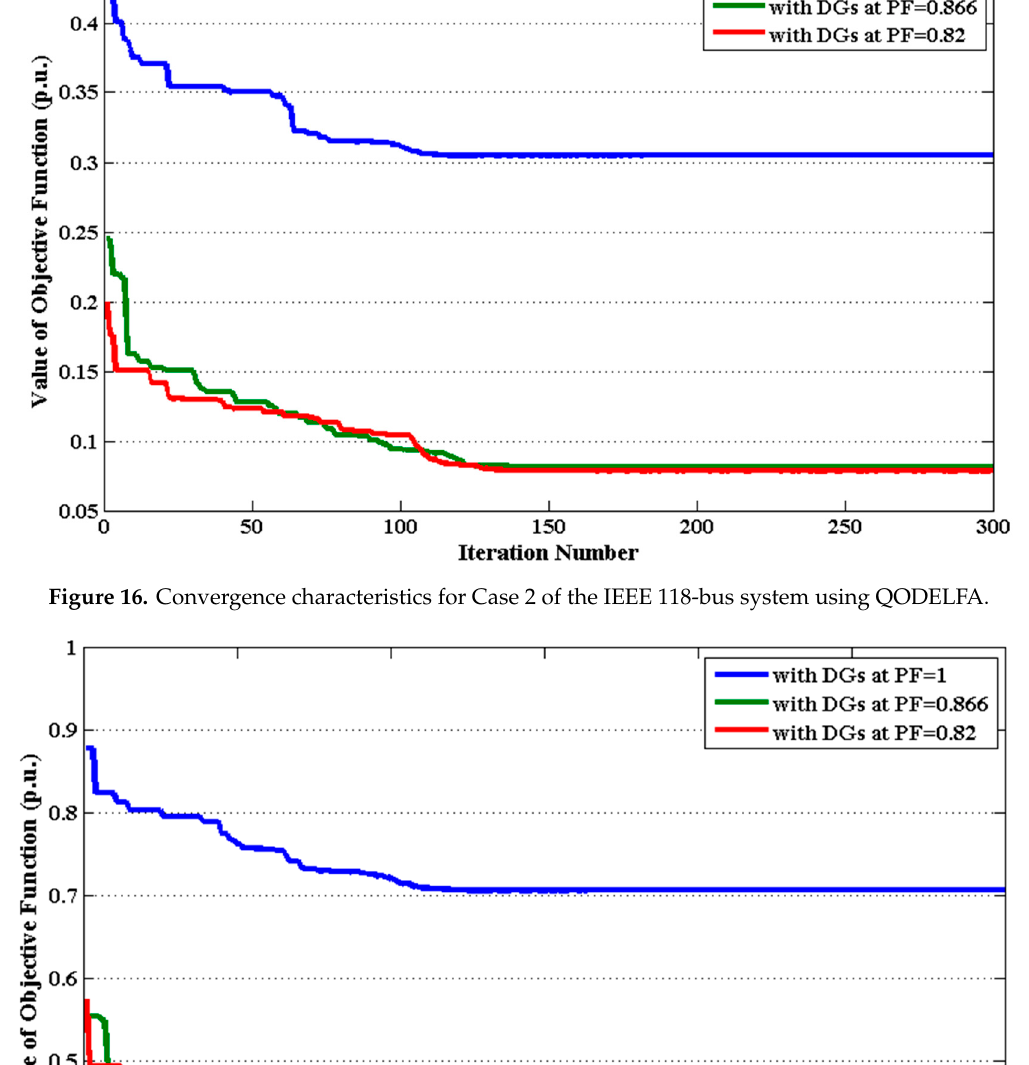
Figure 17. Convergence characteristics for Case 3 of the IEEE 118-bus system using QODELFA.